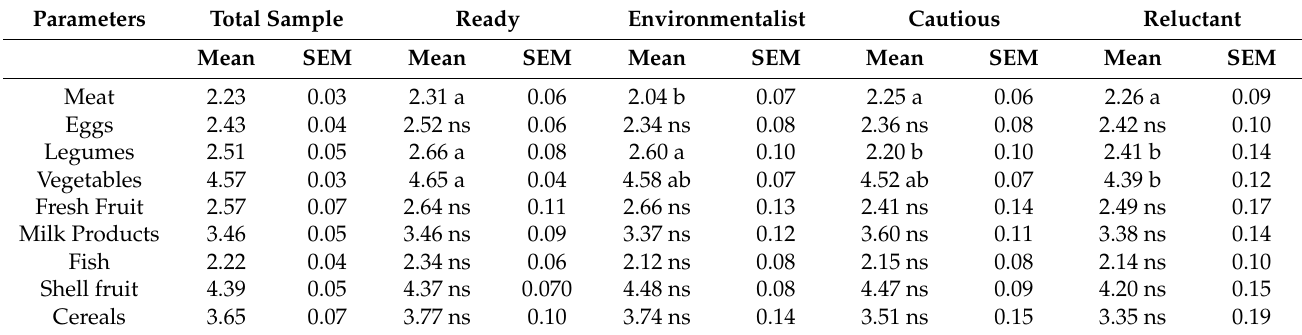
Table 5. Average consumption of selected food types, based on frequency (1: never, 2: once a week, 3: twice a week, 4: more than twice a week, 5: every day) for total population and consumer